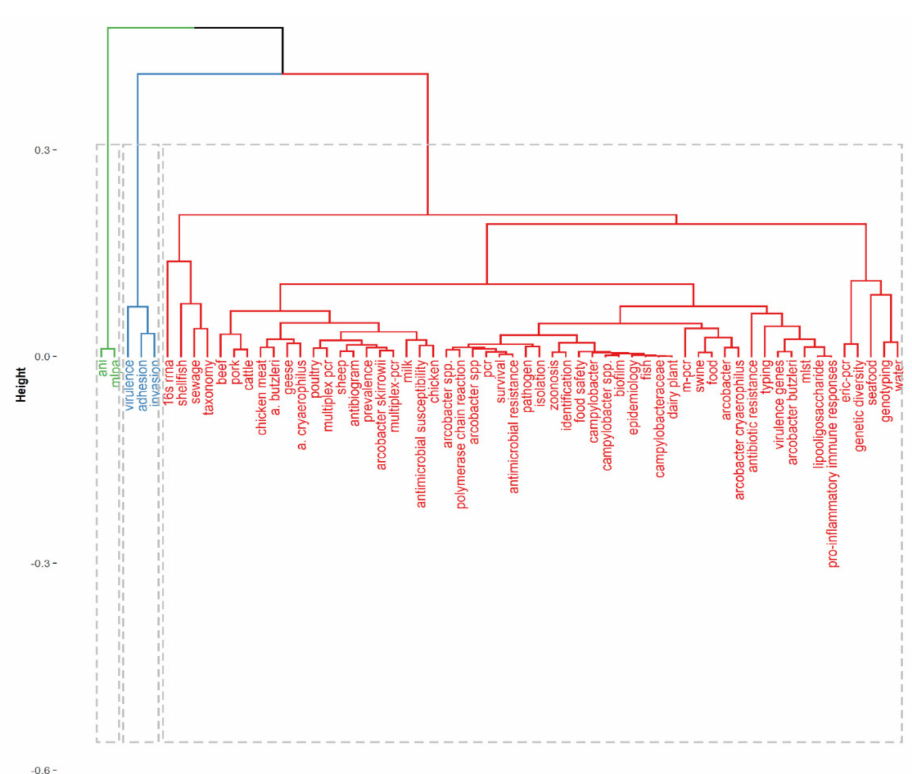
Figure 7. Hierarchical clustering of authors’